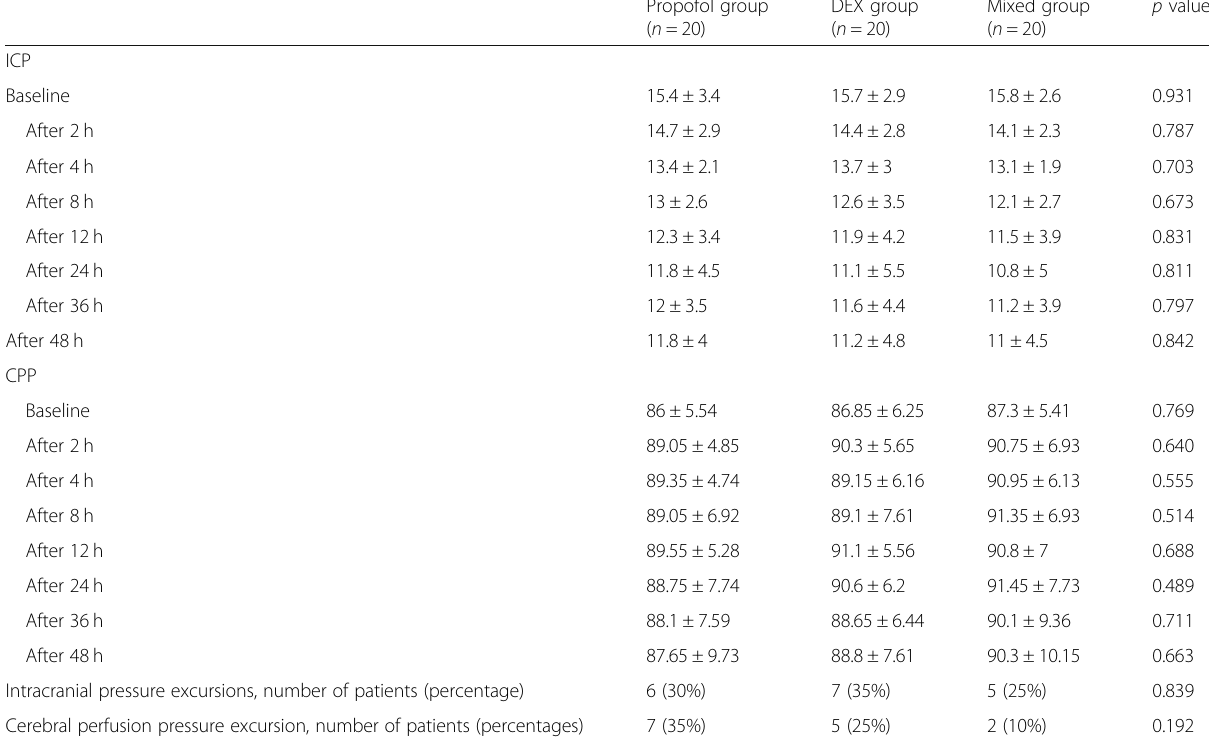
Table 4 Intracranial and cerebral perfusion pressure changes and excursions in the studied groups